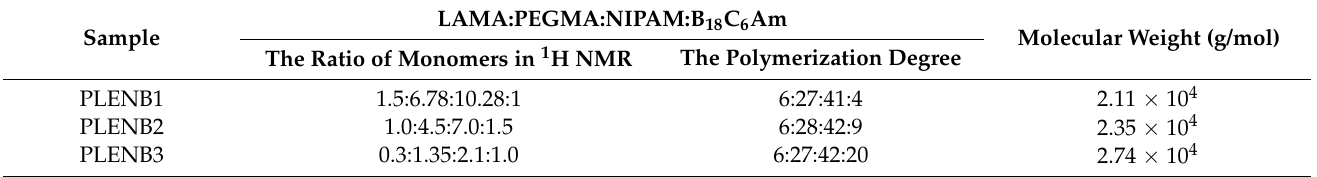
Table 1. The calculation molecular weight of PLENB with different feed